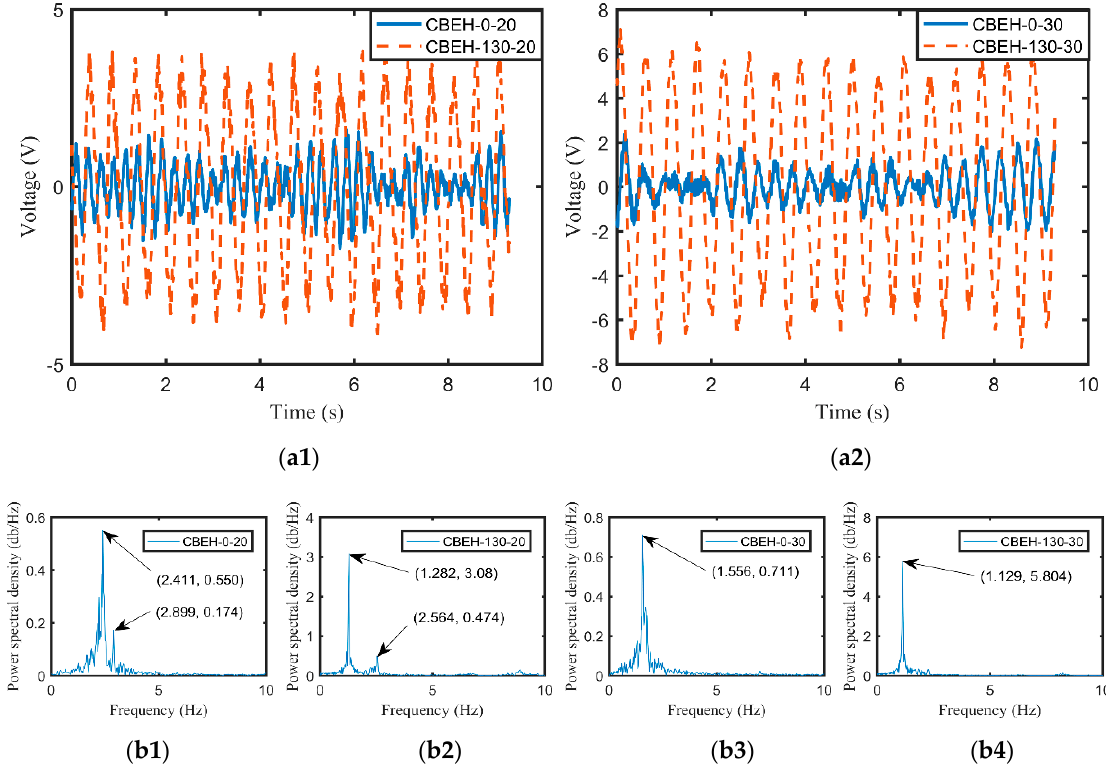
Figure 6. Time history and power spectral density of output voltage for CBEH-0-20, CBEH-130-20, CBEH-0-30, and CBEH-130-30 at 10.52 m / s: ( a ) time history; and ( b ) power spectral density.